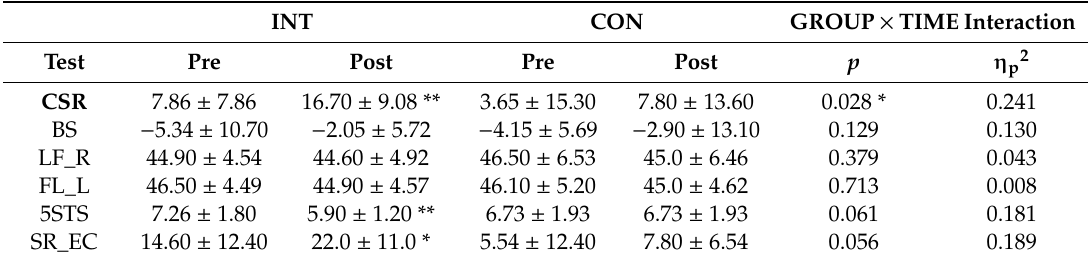
Table 3. Data for pre- and post-testing for the sauna yoga group (INT) and the control group (CON). The rANOVA interaction e ff ects were calculated with baseline values included as covariates, and e ff ect sizes are given as partial eta squared ( η p2